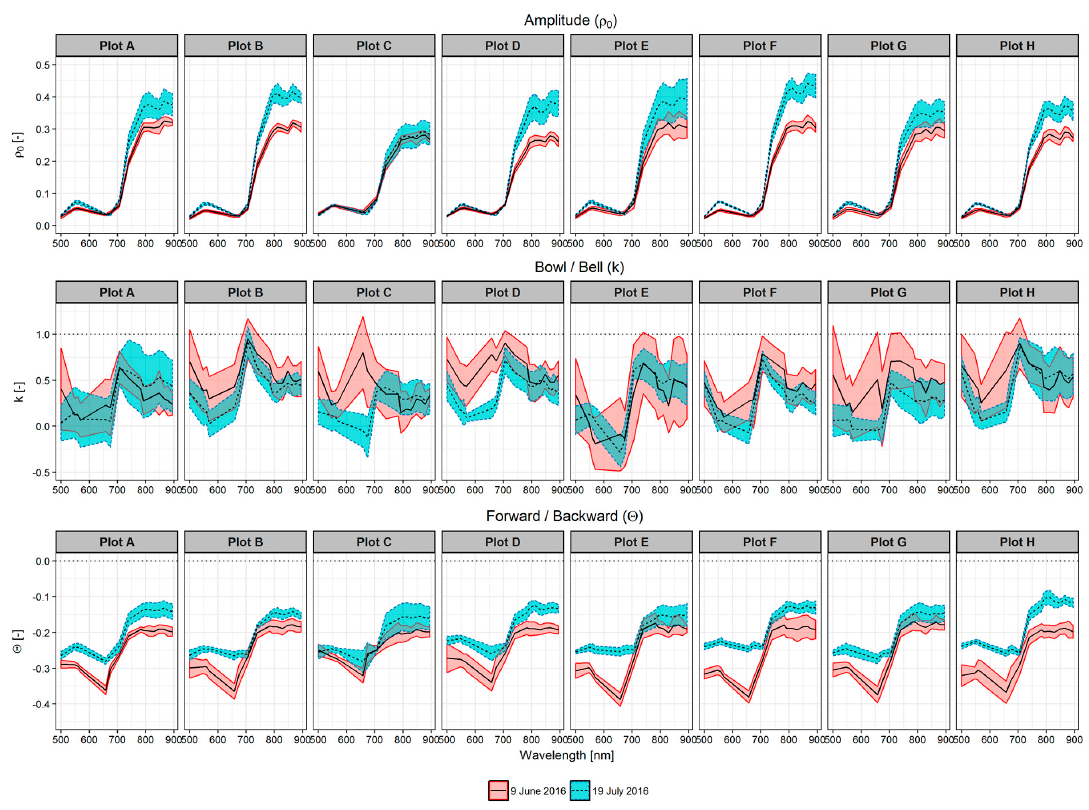
Figure 9. Average ρ 0 , k , and Θ parameters obtained by fitting the RPV model though each individual pixel in the experimental plots on both dates. The colored surfaces indicate the standard deviations.